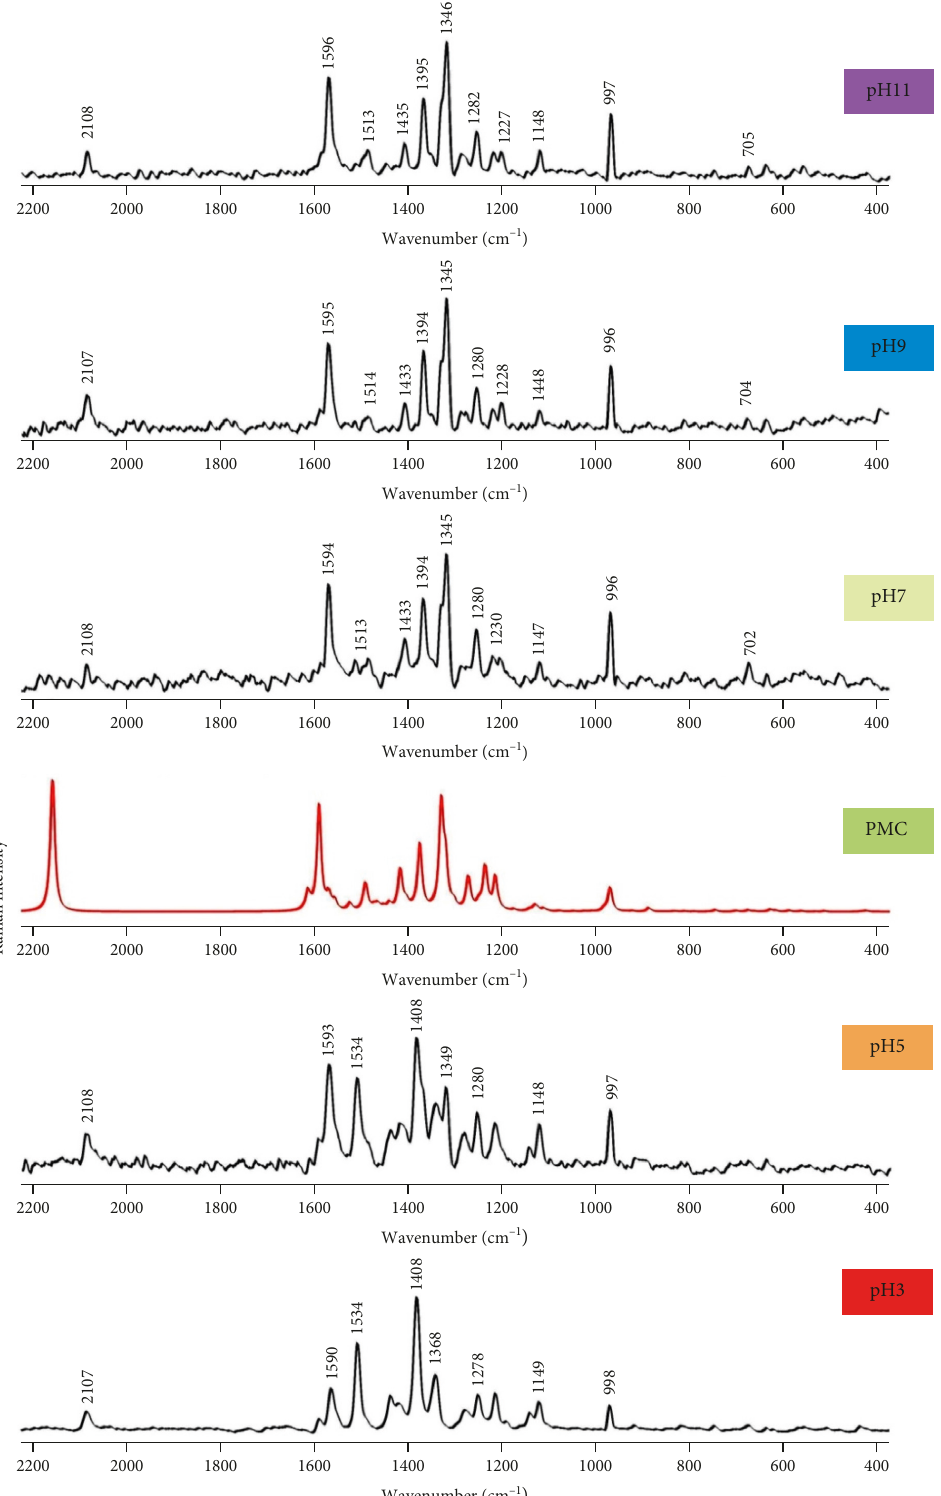
Figure 3: The RS spectra of erlotinib at pH conditions between 3 and 11 (black lines) in the spectral range of 2250–400cm − 1 together with the theoretical bands calculated in the PCM model (red